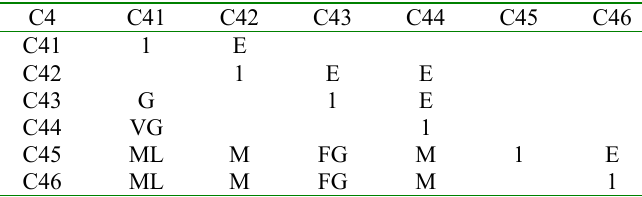
Table 16. Linguistic evaluation matrix of DM3 for C4 sub-criteria